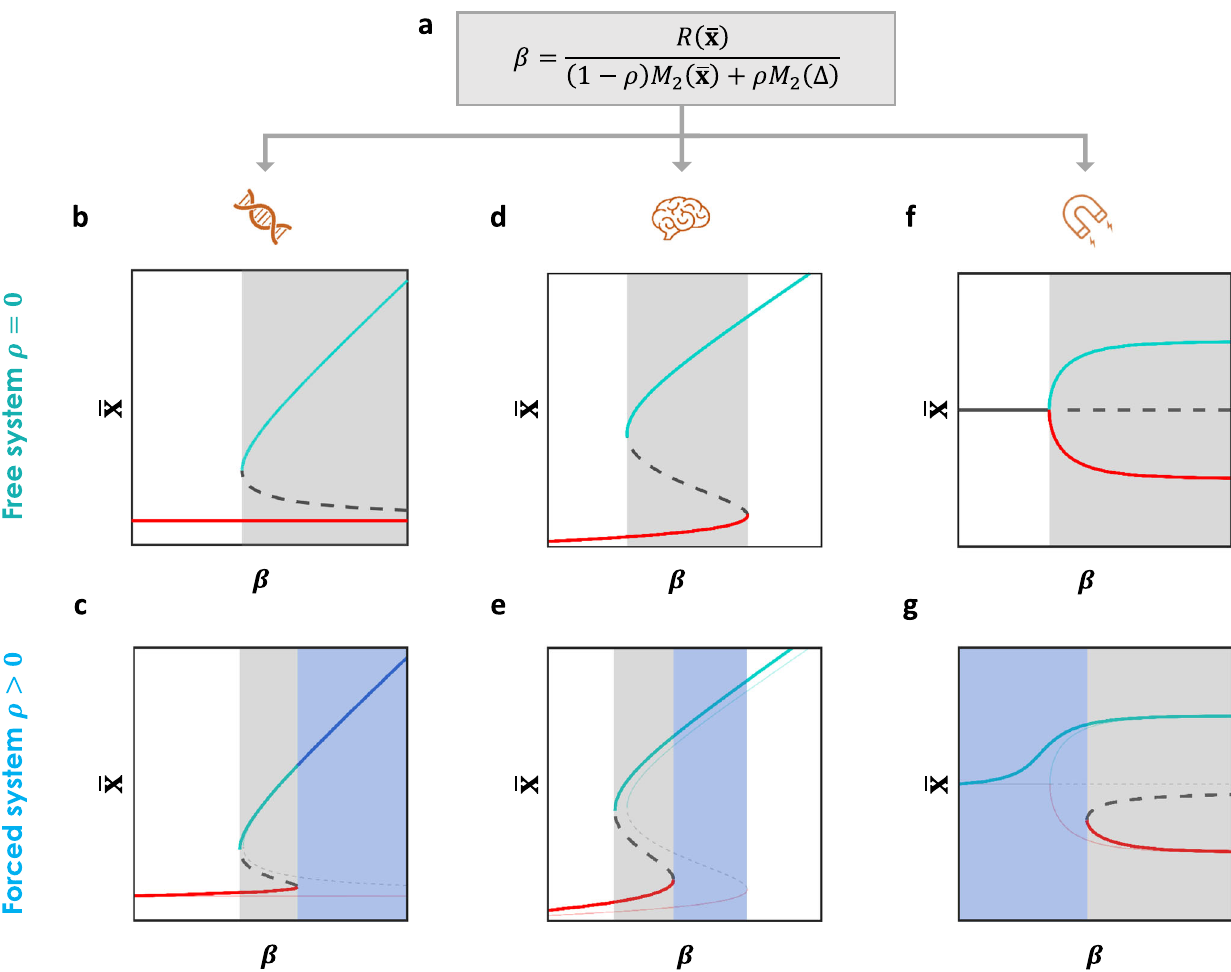
Fig. 2 Theory. The forced system has a new phase diagram. a The relation, Eq. (8), between the system state ( 〈 x 〉 ) and its connectivity ( β ) provides the phase diagrams of both free ( ρ = 0) and controlled ( ρ > 0) systems for any dynamics. Here we demonstrate this for three distinct systems. b , c Cellular dynamics. b A free system diagram shows a suppressed function at x 0 for small β , and a bi-stable regime for large β , where x 0 and x 1 both exist and are stable. Thus the system is unsustainable and has a risk to fail into a nonfunctional state. c In contrast, a forced system, controlled by holding a fraction ρ of nodes with high-value Δ , shows a new phase diagram, having an s-shape curve, with a new region for large β in which only x 1 appears (blue). Thus, a system in the blue region is now safe and not only active, but also sustainable. d , e Brain dynamics. d A free system exhibits three regimes: inactive for sparse topology, active for dense topology, and bi-stable in between. e Forcing the system with certain Δ and ρ pushes the twist of the s-shape to a lower β -value, and as such, makes the blue regime becoming sustainable rather than bi-stable. f , g Spin dynamics. f A free system has a zero inactive stable state for sparse connectivity, while for dense connectivity, there are two symmetric active states. g Controlled system shows a new phase diagram including a sustainable regime where only the positive stable state appears (blue shade). This dynamics does not fall into the formula in ( a ), however, a similar analysis can be done, see Supplementary Note 4 Section